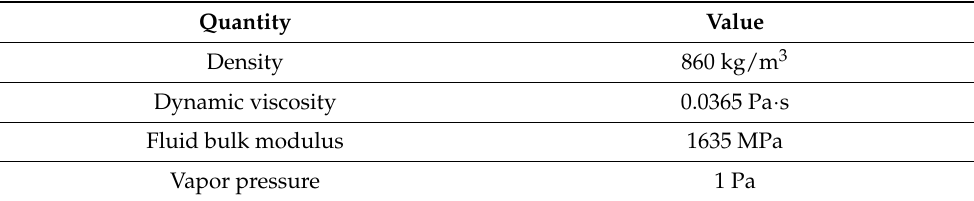
Table 3. Fluid properties of the liquid phase at 40 ◦